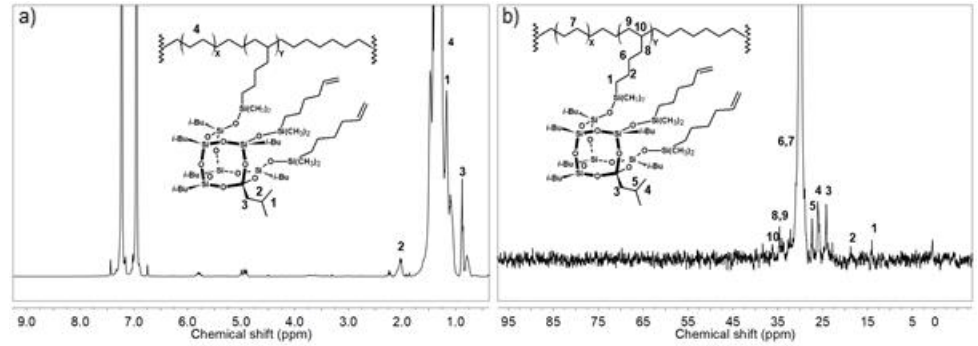
Figure 7. 1 H NMR ( a ) and 13 C NMR ( b ) spectra of E/POSS-6-3 copolymer.